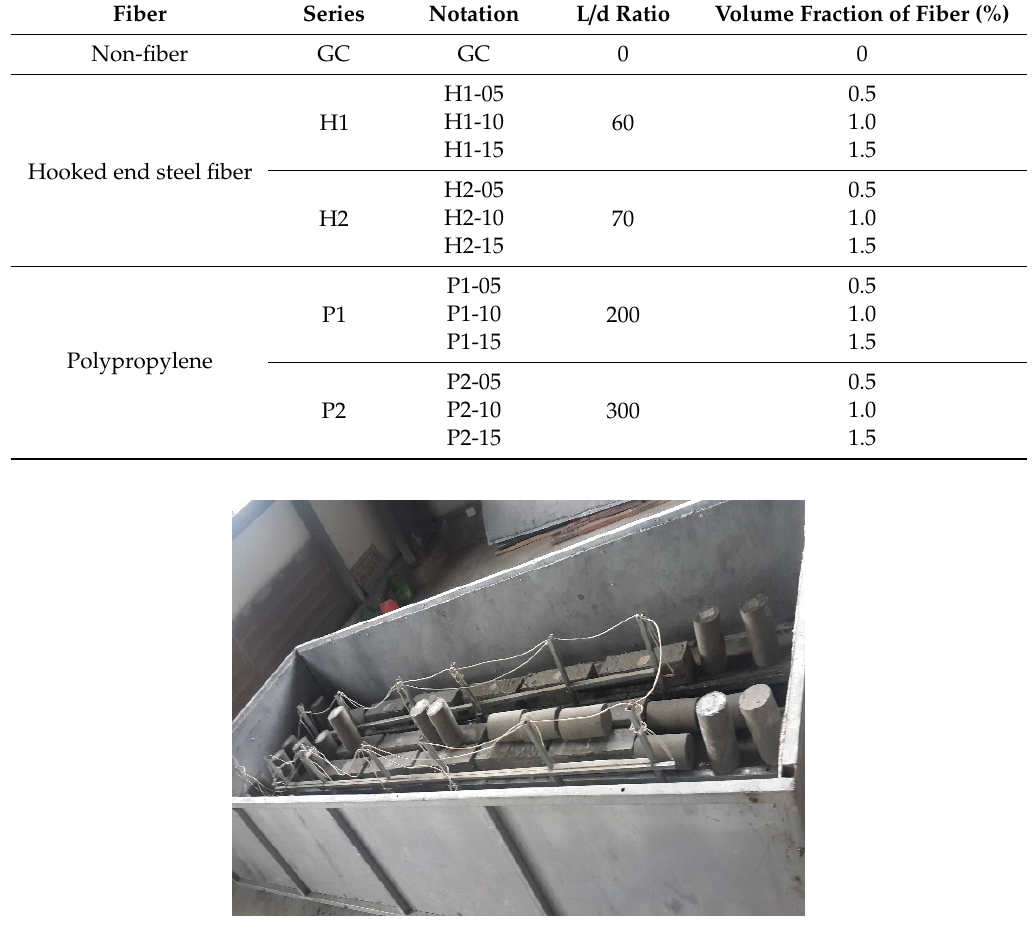
Figure 3. Curing Figure 3. Curing specimens.